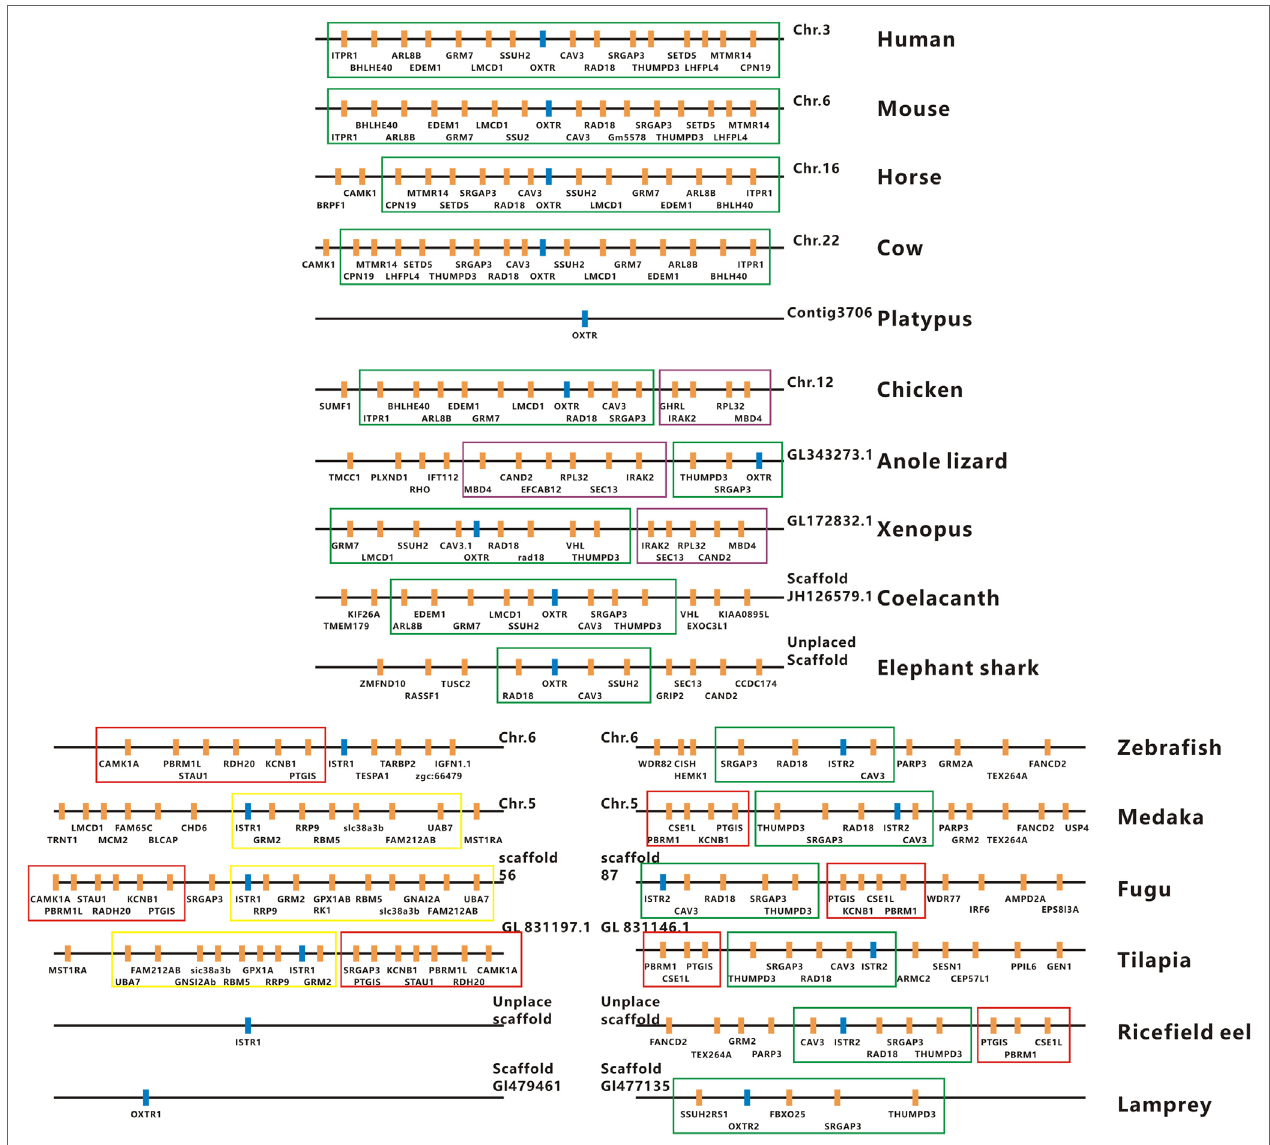
FigUre 2 | Physical maps of the genomic environments around oxytocin-like receptor ( oxtlr ) genes in vertebrates by synteny analysis. The Oxtlr genes are indicated by blue bars and other genes around Oxtlr genes by orange bars. The conserved DNA blocks are denoted by using different colored lines. The green line-boxed DNA blocks include almost the same gene content or gene order in vertebrates, and the purple line-boxed DNA blocks are present specifically in birds, reptiles, and amphibians. The red and yellow line-boxed DNA blocks are present specifically in teleosts. All the genomic data used were downloaded from http://asia.ensembl. org/index.html. Human, Homo sapiens ; Mouse, Mus musculus ; Horse, Equus caballus ; Cow, Bos taurus ; Platypus, Ornithorhynchus anatinus ; Chicken, Gallus gallus ; Anole lizard, Anolis carolinensis ; Xenopus, Xenopus tropicalis ; Coelacanth, Latimeria chalumnae ; Elephant shark, Callorhinchus milii ; Zebrafish, Danio rerio